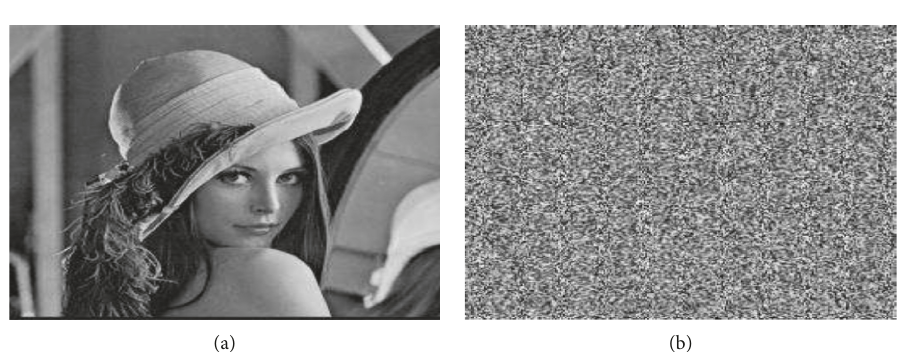
Figure 14: Encrypted Lena image. (a) Original Lena image. (b) Encrypted Lena image.